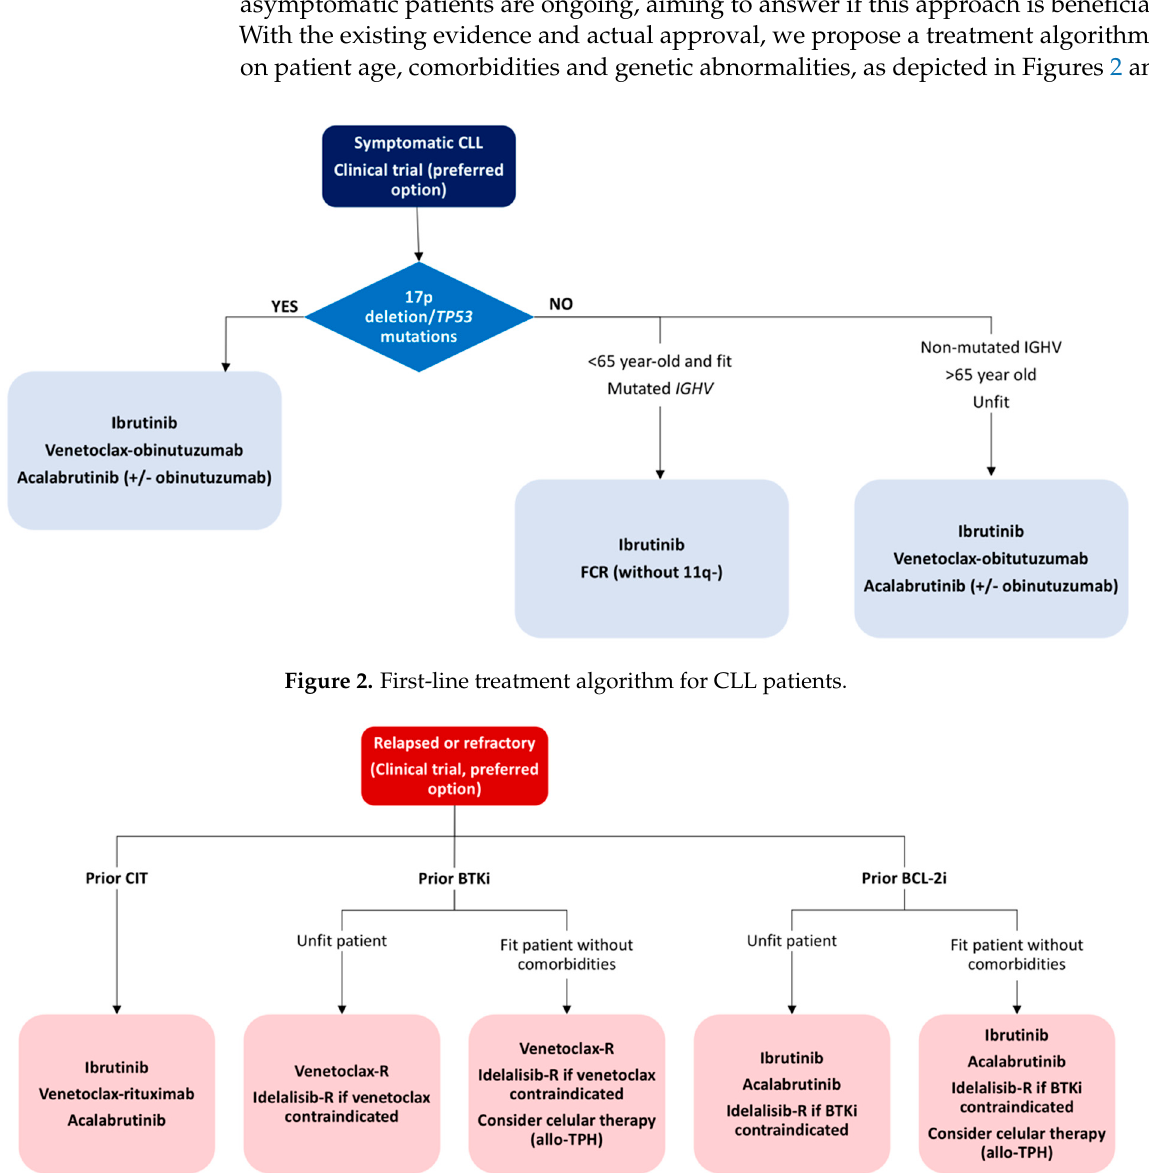
Figure 3. Treatment algorithm for relapsed or refractory CLL patients. CIT: chemoimmunotherapy; BTKi: Bruton tyrosine kinase inhibitor; R: rituximab; allo-TPH: allogeneic stem cell transplantation; BCL-2i: BLC2 inhibitor.